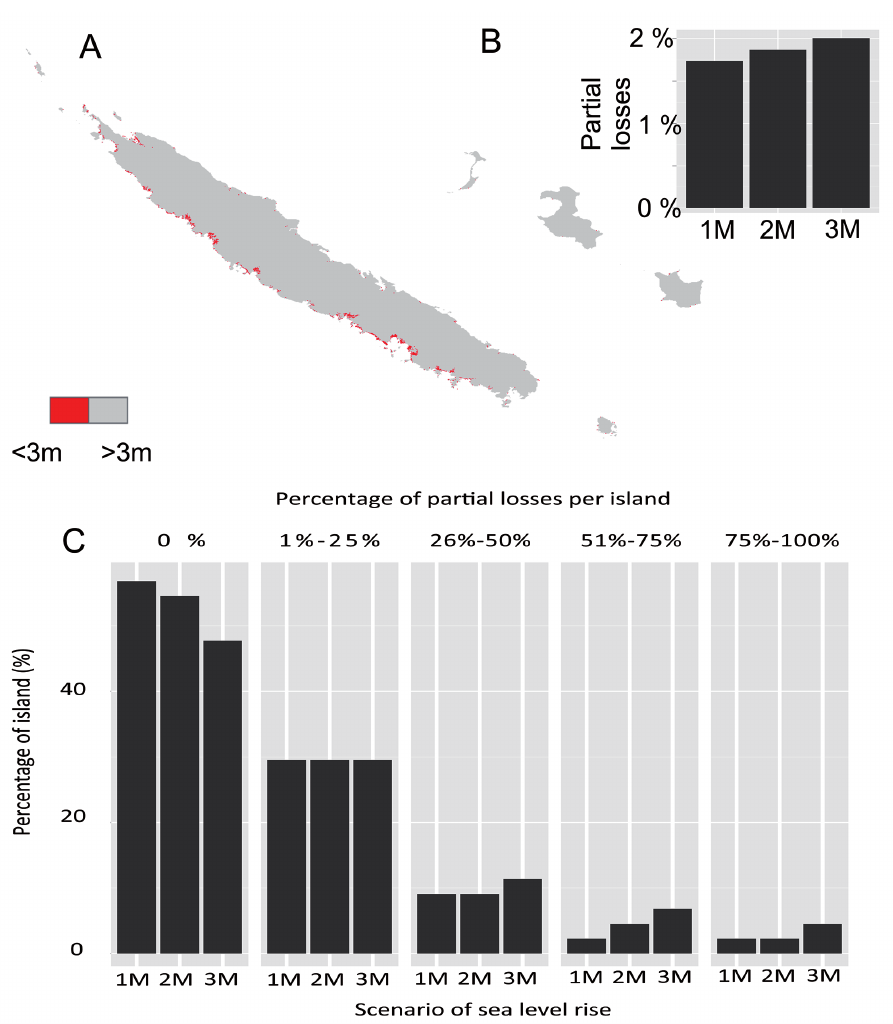
Figure 4. A Map representing the partial habitat losses of New Caledonia region with an increase of sea level by 3 meters B Percentage of areas partially submerged in New Caledonia region under an increase of sea level by 3 meters C Percentage of island that are partially submerged for different classes of